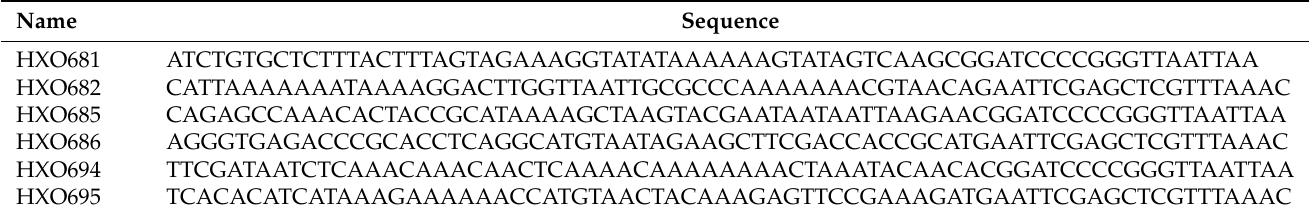
Table 2. Oligonucleotide primers used in this